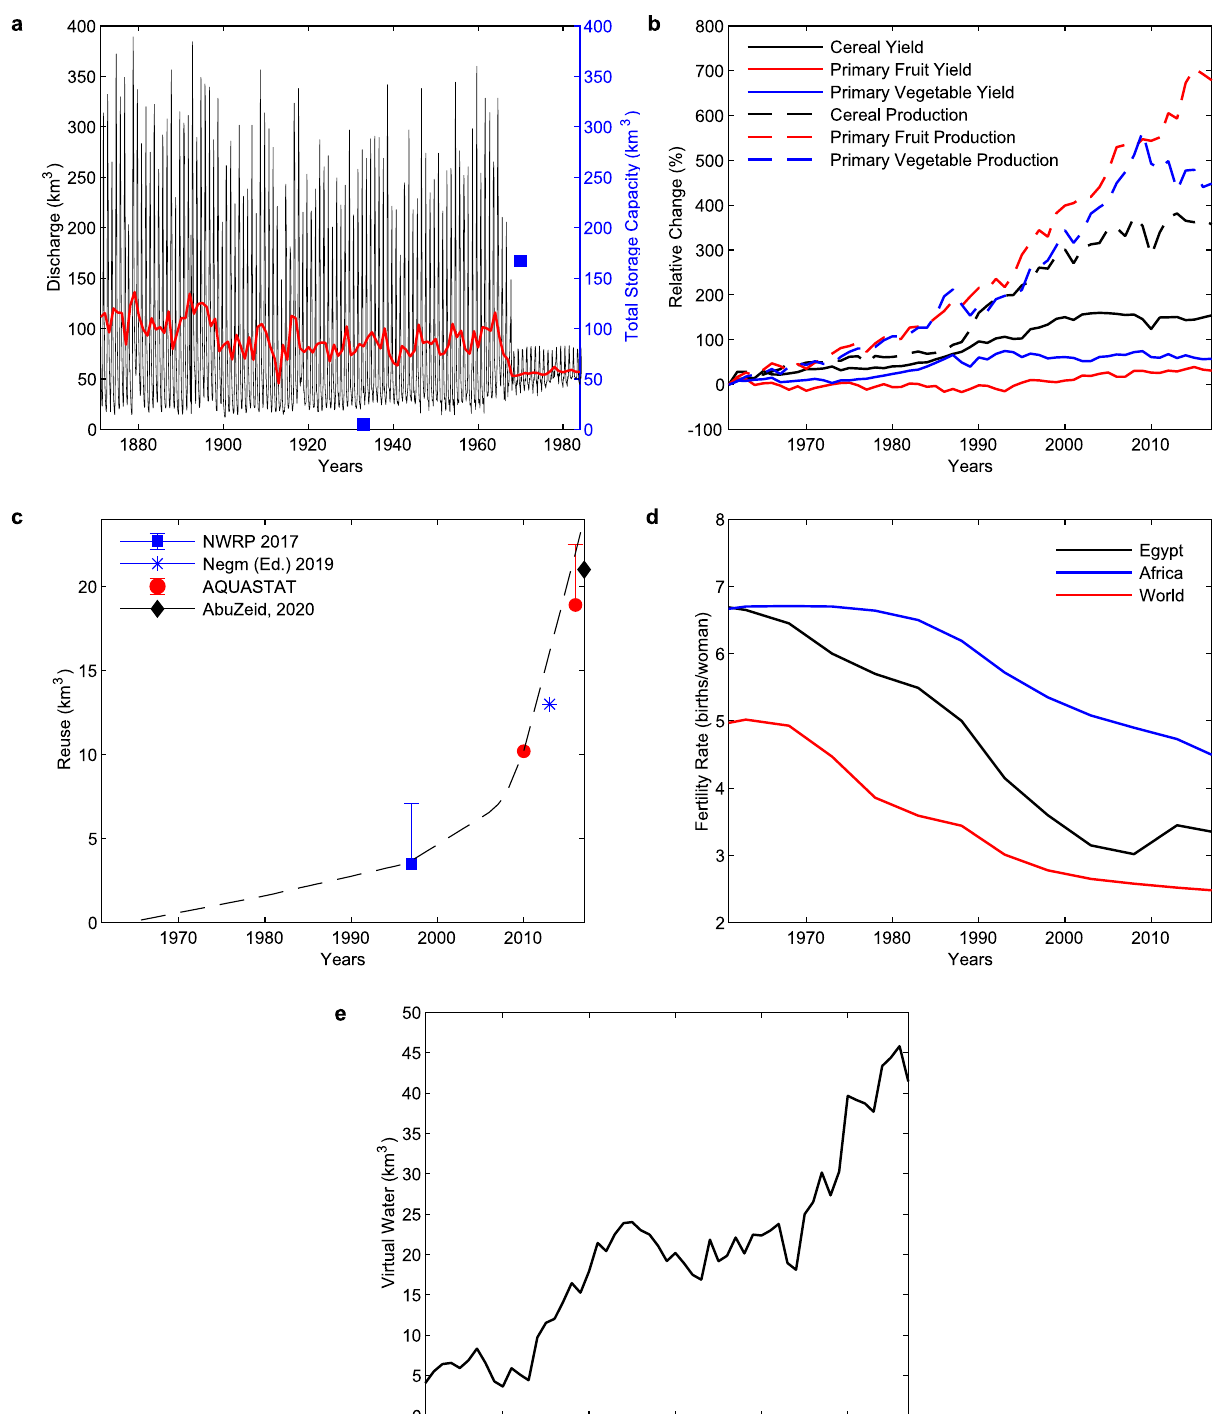
Fig. 2 Egypt ’ s response. a Flow of the Nile at Aswan in monthly [black line] and yearly [red line] averages 16 (Supplementary Table 1.20). Blue squares represent the total storage capacity and marks the construction of the Aswan and High Aswan Dams 12 (Supplementary Table 1.19). b production (harvested tonnes) [dotted lines] and yield (production/area) [solid lines] of cereal [black], primary fruit [red], and primary vegetable [blue] crop groupings. 1961 production values are 5.0, 1.9, and 2.8 million tonnes respectively, and 1961 yield values are 29,057, 169,113, and 152,611 hg/ha respectively (Supplementary Table 1.7). c Estimated water available for reuse from direct agricultural drainage reuse, Nile Delta and Valley groundwater, and treated wastewater reuse. The error bars shown account for estimates of wastewater reuse in the absence of data for those years 22,23,25,51 . Sources for individual components in Supplementary Fig. 9. The black dotted line shows the reuse timeseries used in analysis. d Total Fertility Rate (births/woman) plotted for Egypt [black line], Africa on average [blue line], and the world on average [red line] 29 (Supplementary Table 1.5). e Virtual water imports (km 3 ) of agricultural goods (primary and secondary crops and animal products) scaled to Egypt use equivalent (Supplementary Tables 1.1, 1.2, 1.3, and